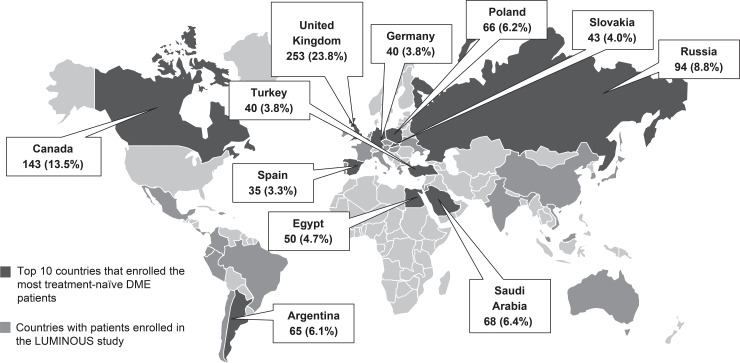
LUMINOUS study overview: World map showing overall recruitment with countries enrolling highest treatment-naïve patients with DME.The pop out boxes represent the number (%) of treatment-naïve patients with DME in the top. Equal recruitment numbers were achieved in Turkey and Germany. DME, diabetic macular edema.